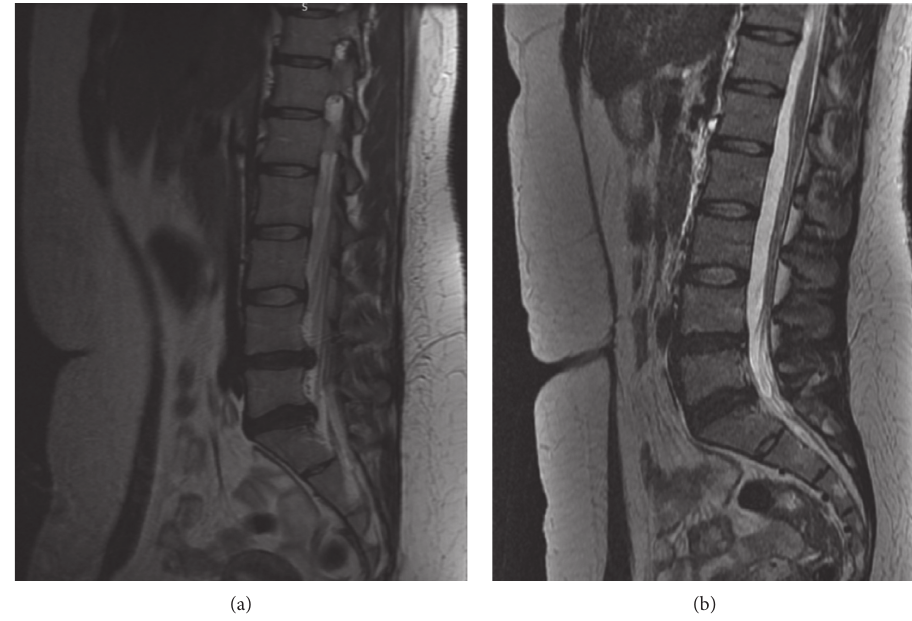
Figure 1: MRI. Date of examination: (a) 4 th December 2018 and (b) 20 th September 2019.